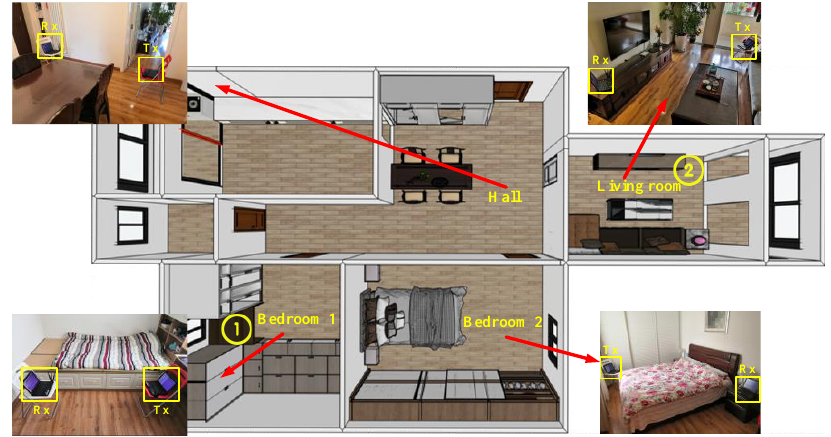
Figure 9. Experimental environment.